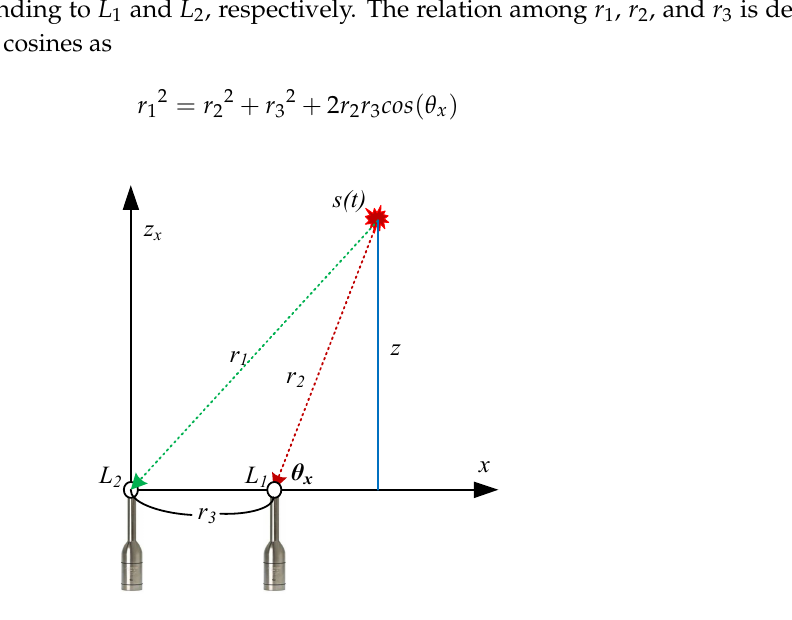
Figure 5. Estimation of the prediction plane z -axis value.